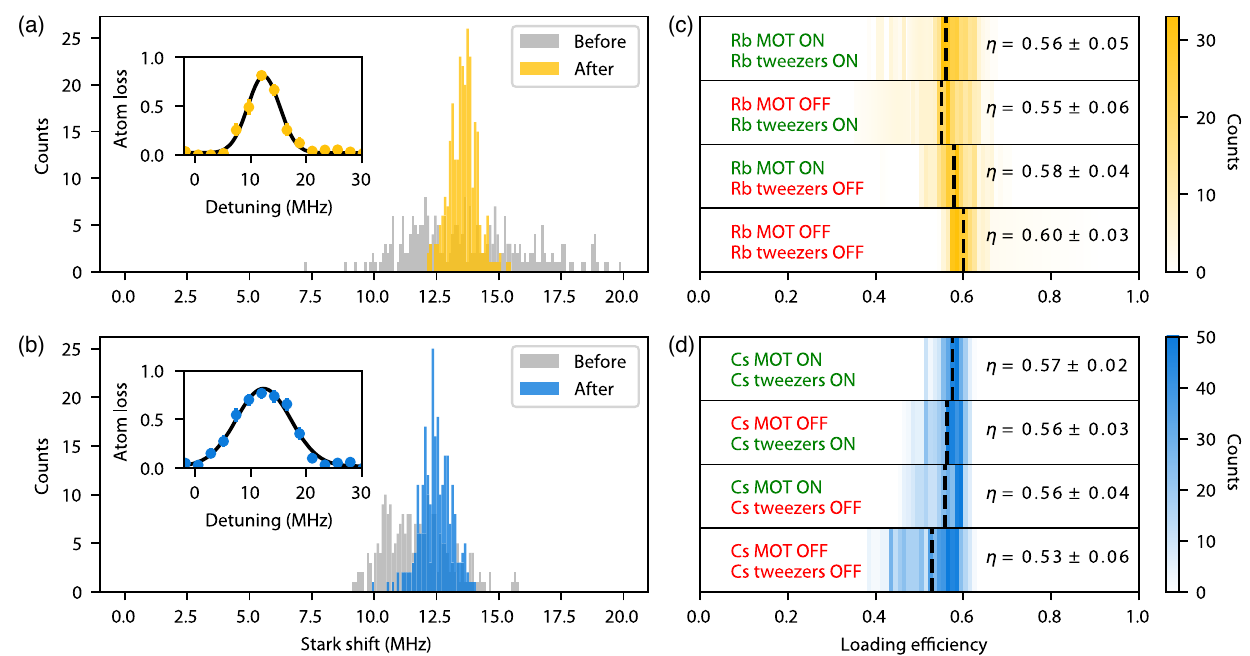
FIG. 3. Homogeneity and loading statistics for the Rb and Cs arrays. (a) Stark shifts across a 17 × 16 Cs array before (gray) and after (yellow) trap intensity correction via the weighted Gerchberg-Saxton algorithm based on feedback from the atoms. Inset provides an example Stark shift measurement in which the frequency of a pushout beam is swept to determine the trap-induced ac Stark shift. (b) Stark shifts across a 16 × 15 Rb array before (gray) and after (blue) trap intensity correction via the optimization of the rf tones driving the AODs based on feedback from the atoms. Inset provides an example Stark shift measurement. (c) Loading statistics for the Cs array with and without the presence of the Rb MOT and Rb tweezers. Dashed line indicates the average loading efficiency. Reported loading efficiency errors are the standard deviations of their respective distributions. (d) Loading statistics for the Rb array with and without the presence of the Cs MOT and Cs tweezers. Dashed line indicates the average loading